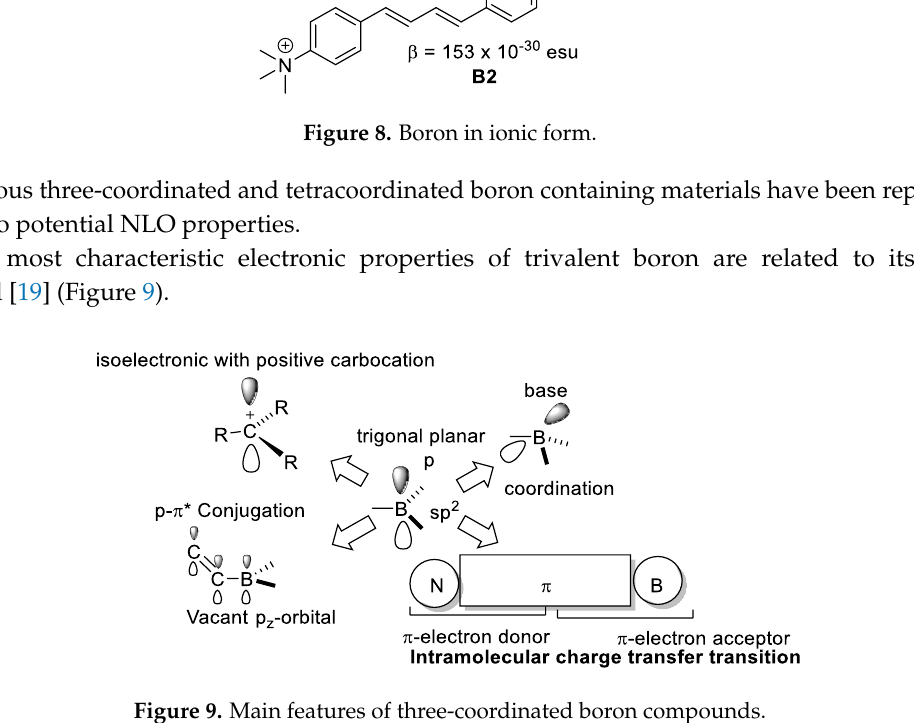
Figure 7. Boron in ionic form.